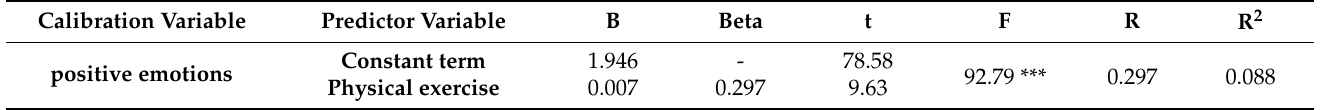
Table 6. Results of regression analysis of physical exercise on positive emotions. Calibration Variable Predictor Variable B positive